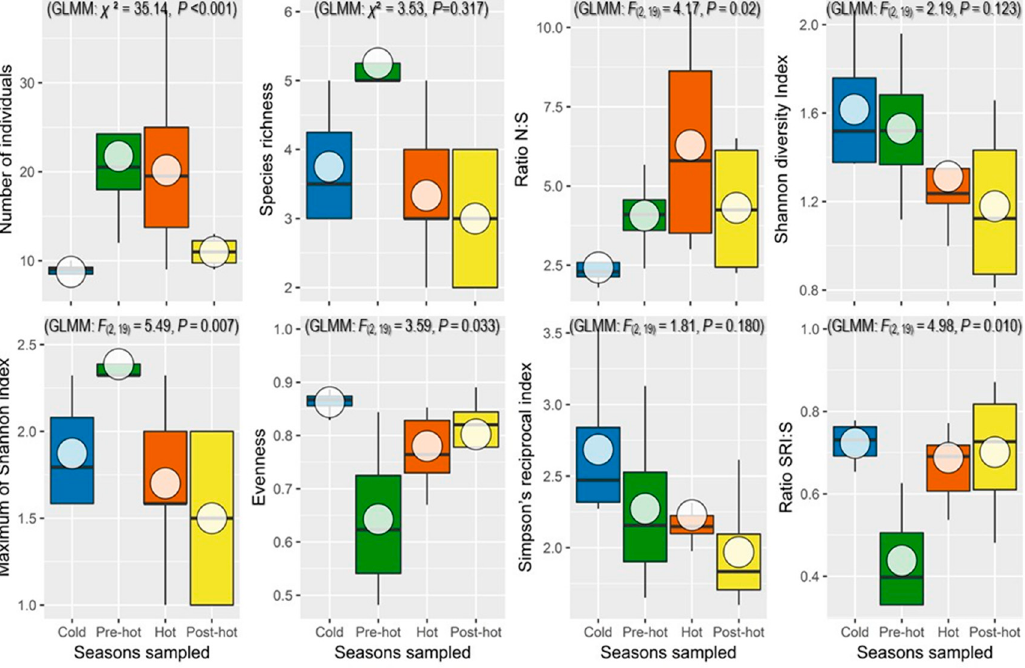
Figure 3. Box plots representing the di ff erent ecological indices applied to scorpion assemblages sampled during di ff erent